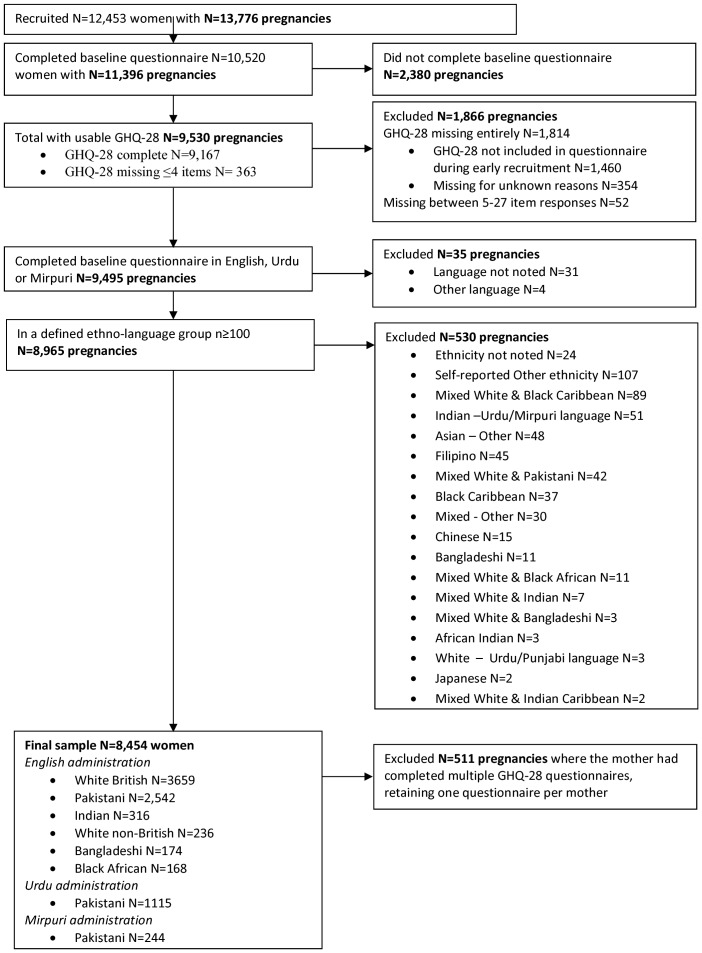
Study flowchart.